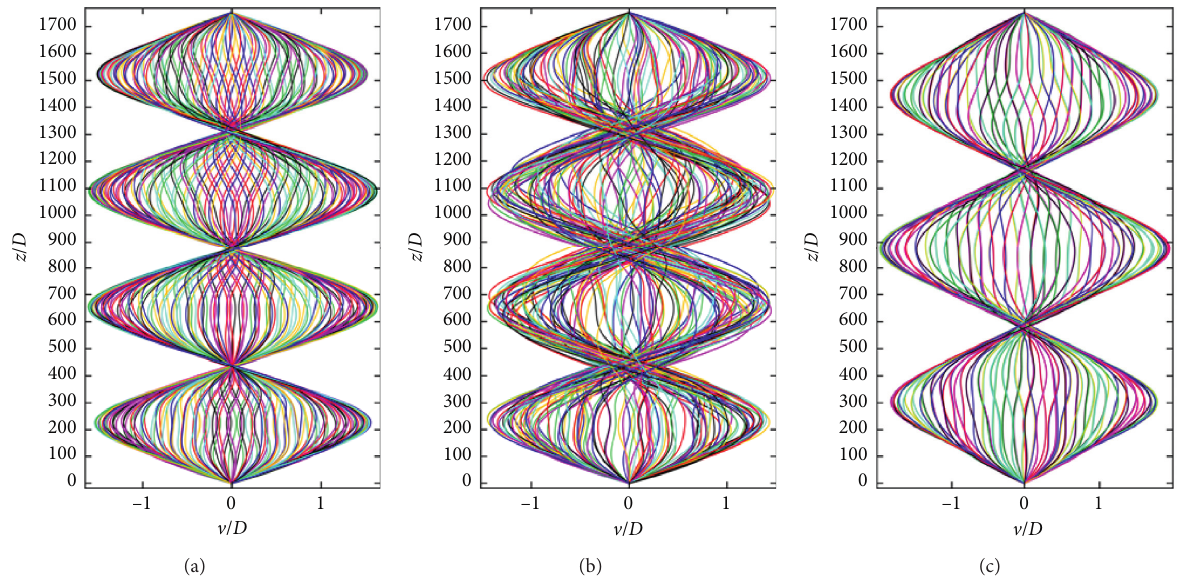
Figure 14: Vibration response modes under the condition of different gas-phase volume fractions with (a) ε (c) ε g �